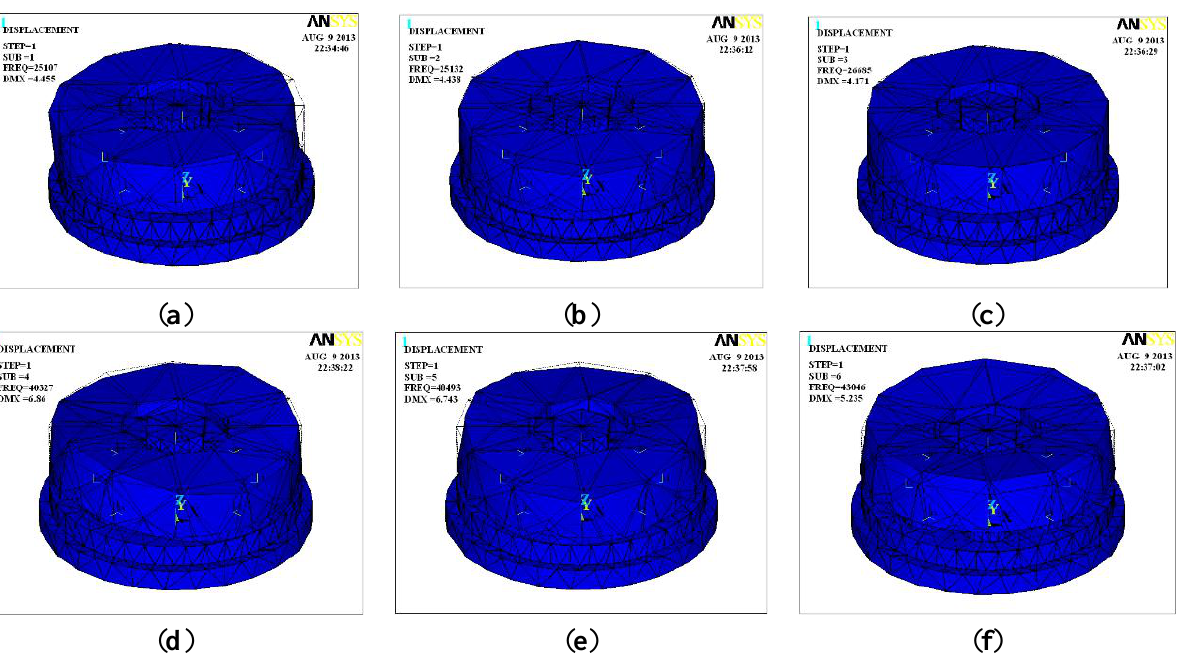
Figure 4. Inherent vibration modes of the piezoelectric six-DOF accelerometer. ( a ) 1th vibration mode; ( b ) 2th vibration mode; ( c ) 3th vibration mode; ( d ) 4th vibration